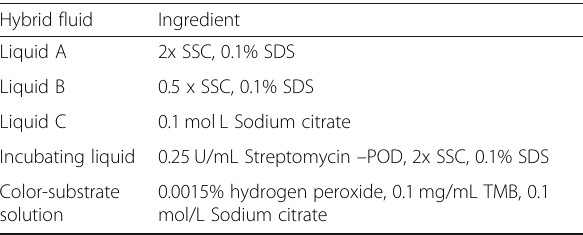
Table 3 Hybridization components used in molecular hybridization analysis Hybrid